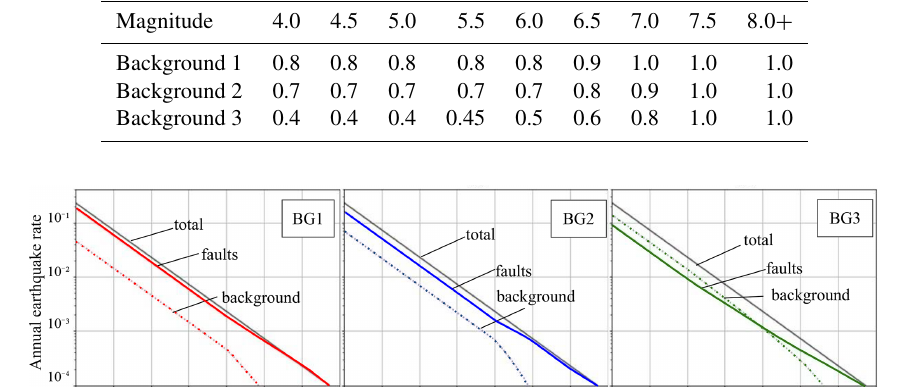
Table 4. Ratio of earthquakes assumed to be on the faults over the total number of earthquakes in the system for each background hypothesis.